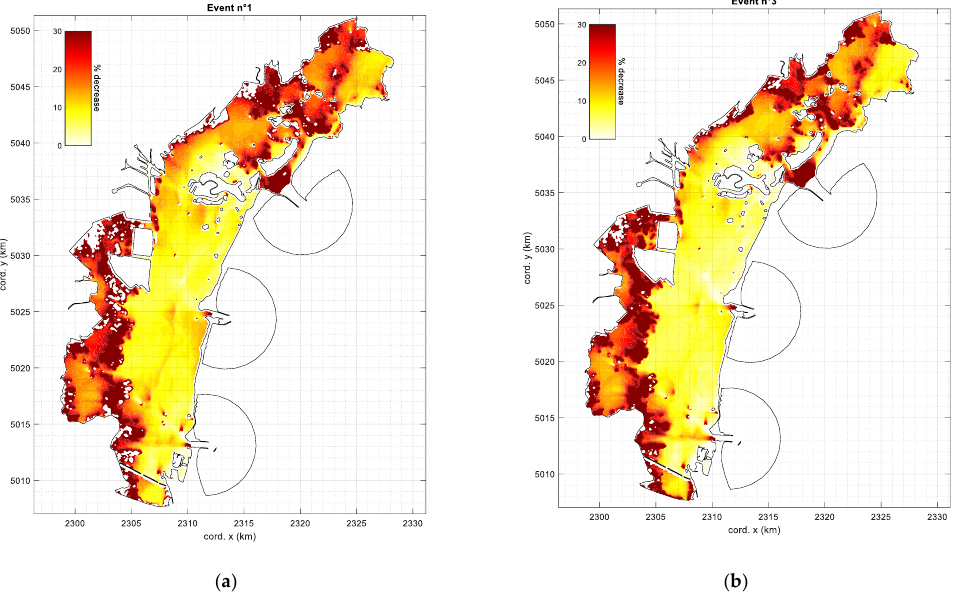
Figure 8. Percentage decrease between the modelled H S in the closed and open barrier scenarios for ( a ) event no. 1 (3 October 2020) and ( b ) no. 3 (5 December 2020). In the red, the decreases are larger than 30%.